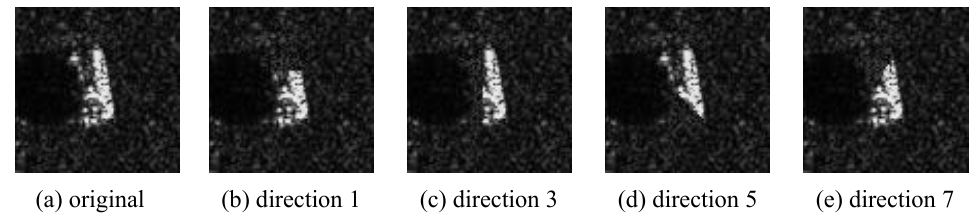
Figure 11. Examples of occluded SAR images from different directions.